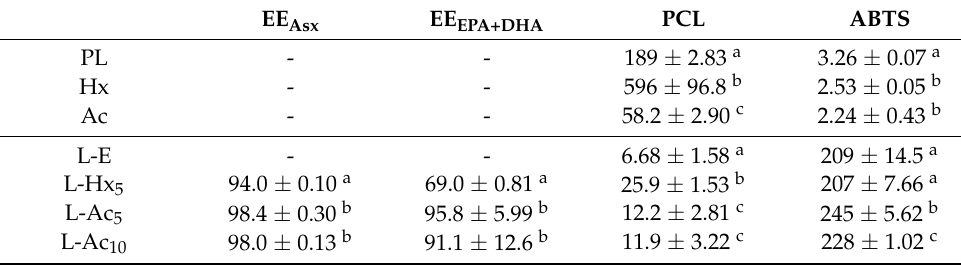
Table 2. Encapsulation efficiency (%) of astaxanthin (EE Asx ) and long-chain ω -3 fatty acids (EE EPA+DHA ); and anti-oxidant capacity of lipid extracts (mg Trolox Eq/g) and fresh liposomes (mg Trolox Eq/L). EE Asx EE EPA+DHA PCL ABTS PL - - Hx -